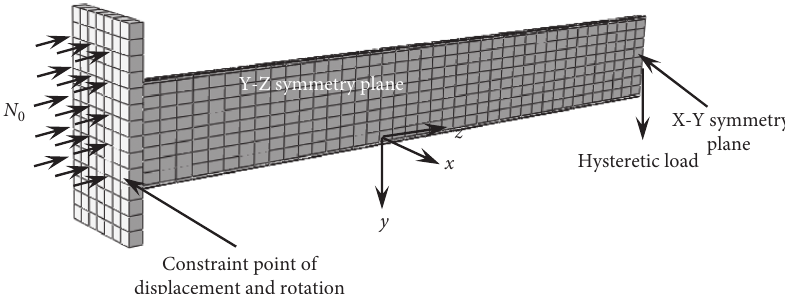
Figure 12: Boundary conditions for the specimens’ finite element simulation.